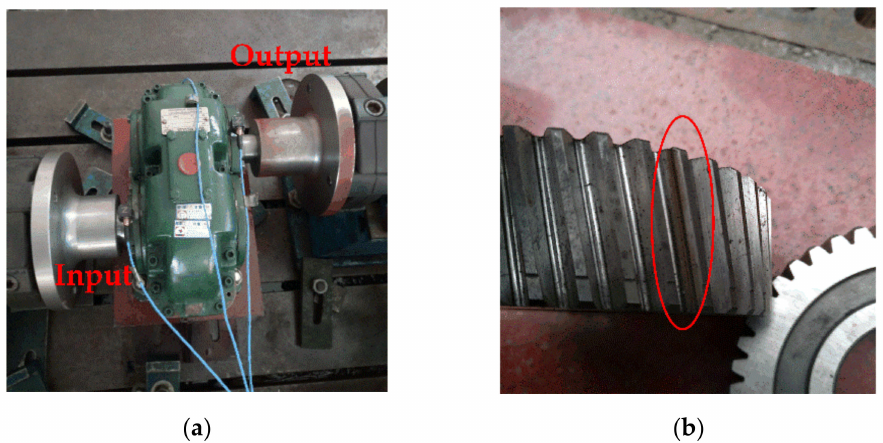
Figure 7. The single-stage gearbox test bench: ( a ) The single-stage gearbox; ( b ) The local fault gear with